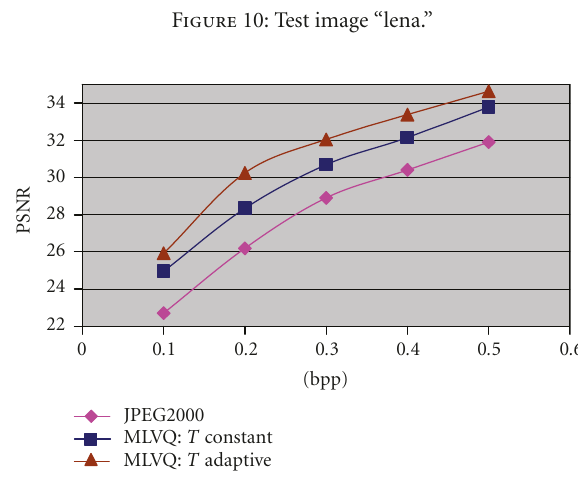
Figure 9: Test image “camera.”